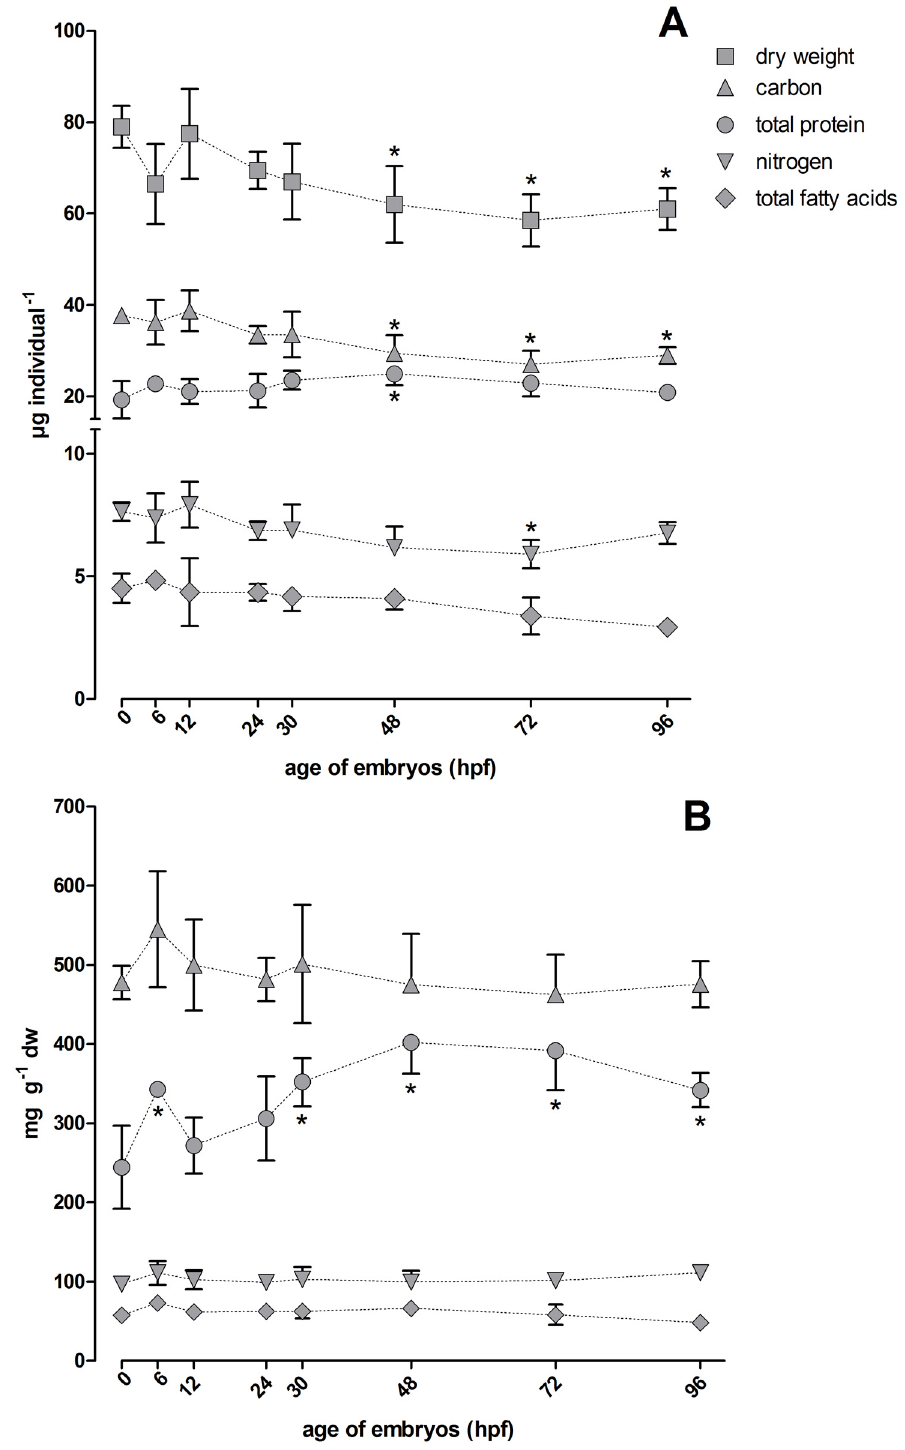
Fig 1. Values for dry weight and for carbon, nitrogen, total fatty acids and protein contents for eggs/ hatched embryos of the zebrafish ( D . rerio ) at different stages of development. (A) Absolute values for the different parameters per individual and (B) relative amounts of carbon, nitrogen, total fatty acids and protein normalized to respective dry weights are depicted. Symbols were connected to visualize trends. * : p < 0.05 (Dunnett ’ s test with 0 hpf as reference). For dry weight, carbon and nitrogen: n = 4 with 5 pooled